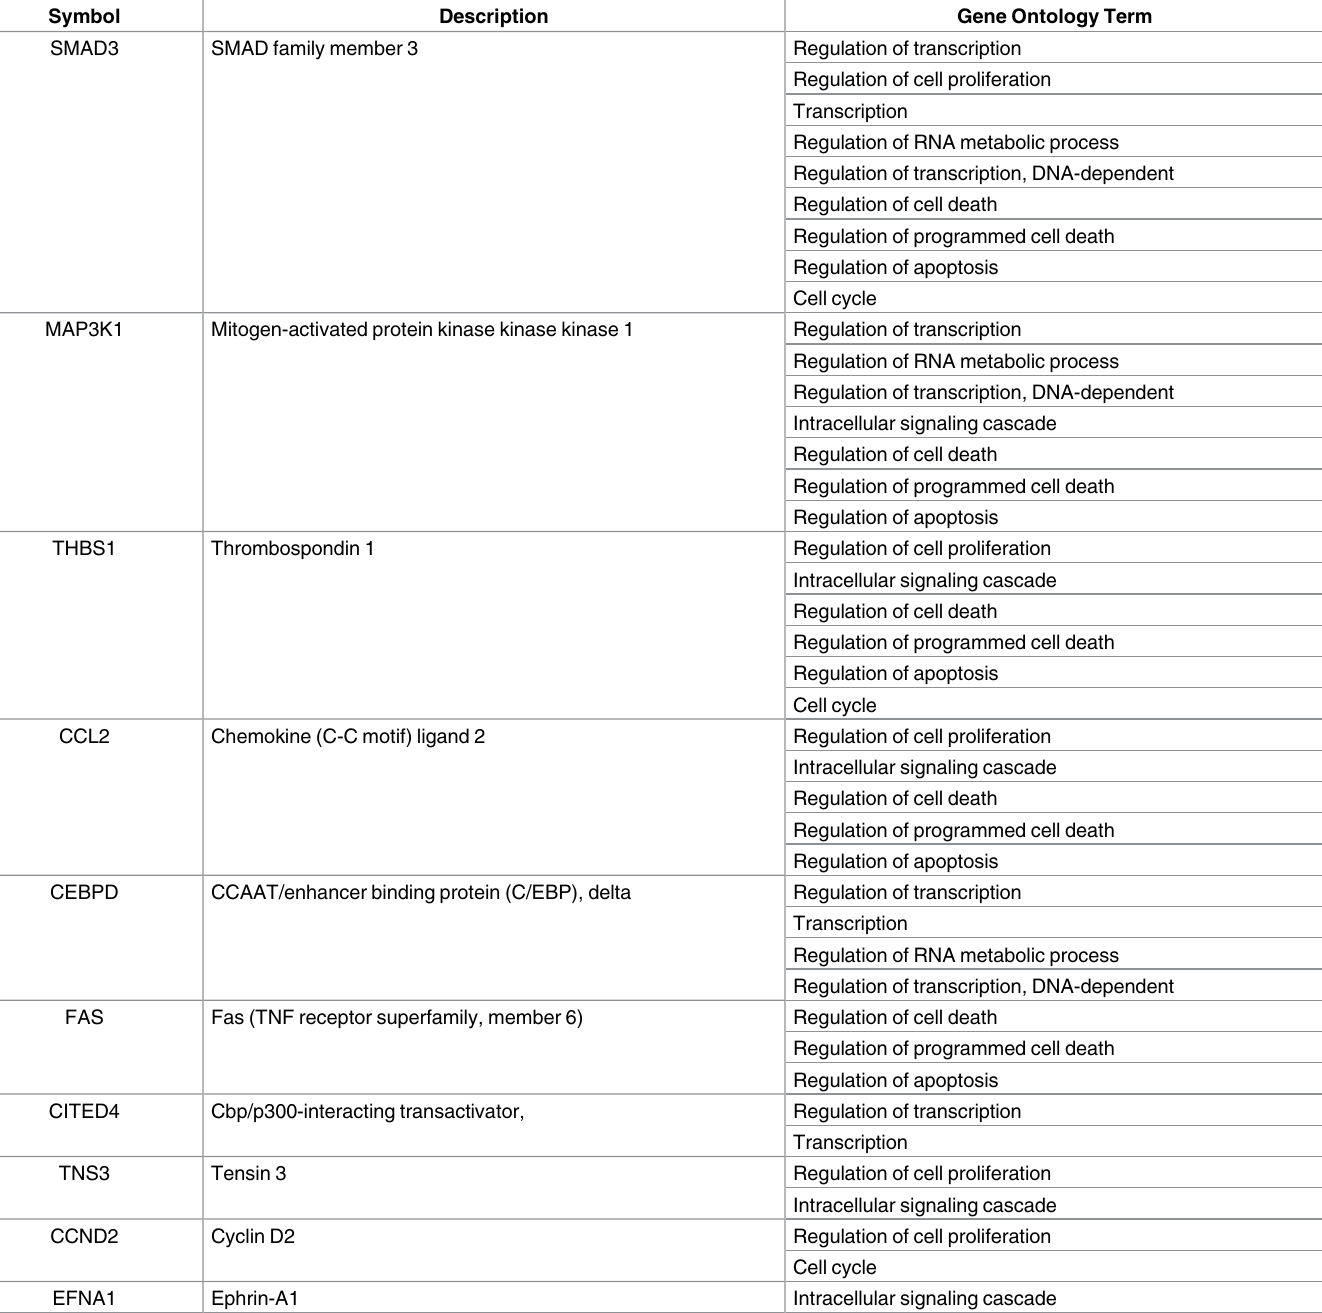
Table 2. The 10 most down-regulated genes found with BP analysis following GE treatment.